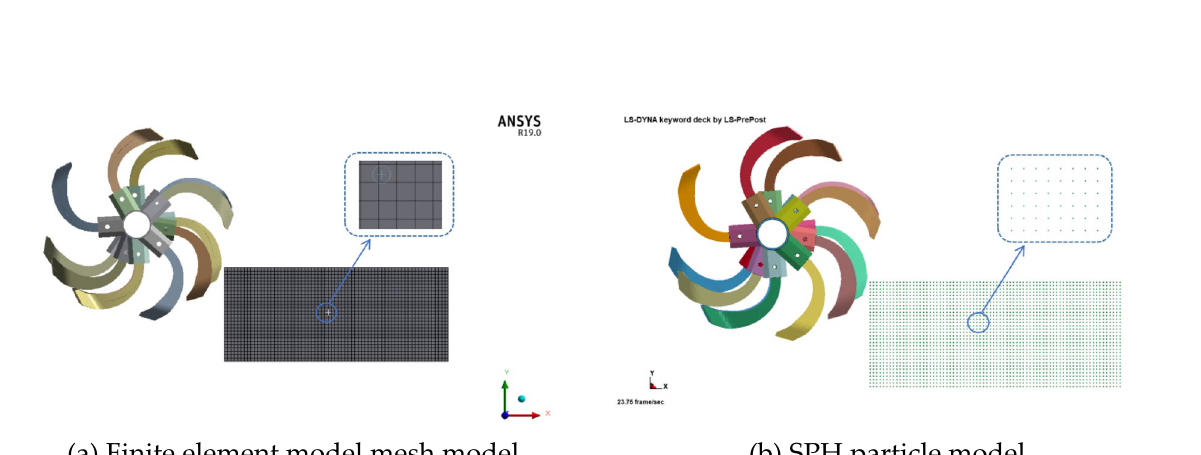
Figure 8. FEM-SPH node transition